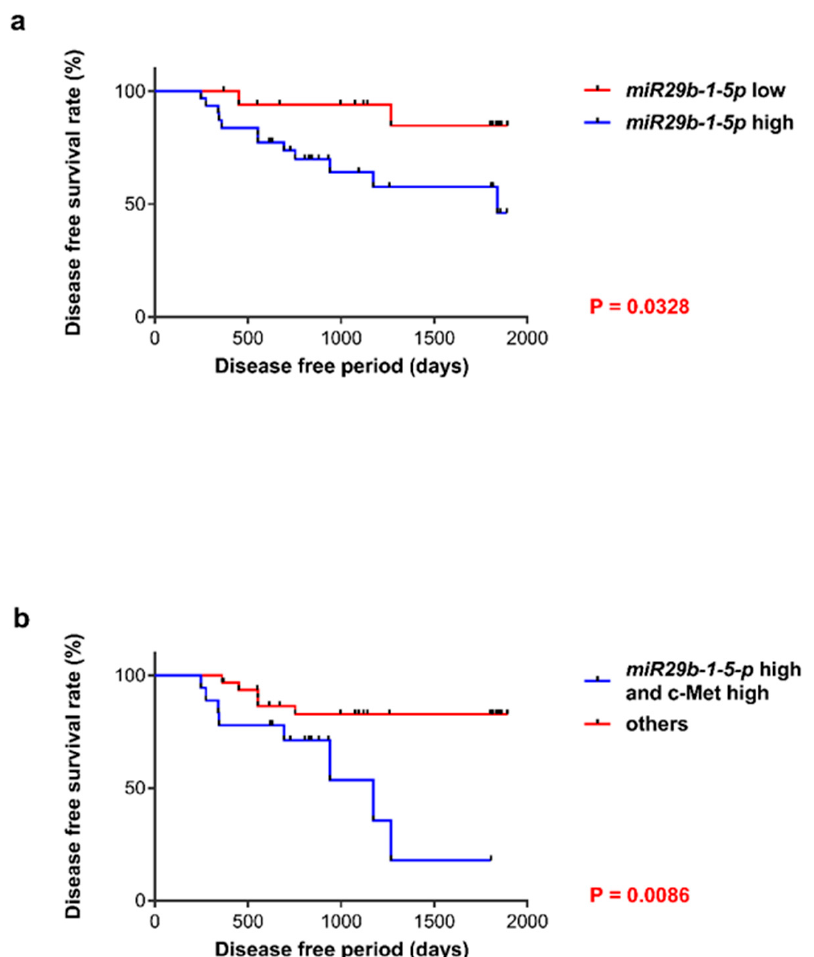
Figure 2. Patients with OSCC. ( a ) Patients with elevated levels of miR-29b-1-5p experienced significantly shorter DFS than those with relatively lower levels of miR-29b-1-5p expression ( p = 0.0328). ( b ) Patients with OSCC along with the concurrent expression of miR-29b-1-5p and c-Met experienced significantly shorter DFS than other patients included in this study ( p = 0.0086).